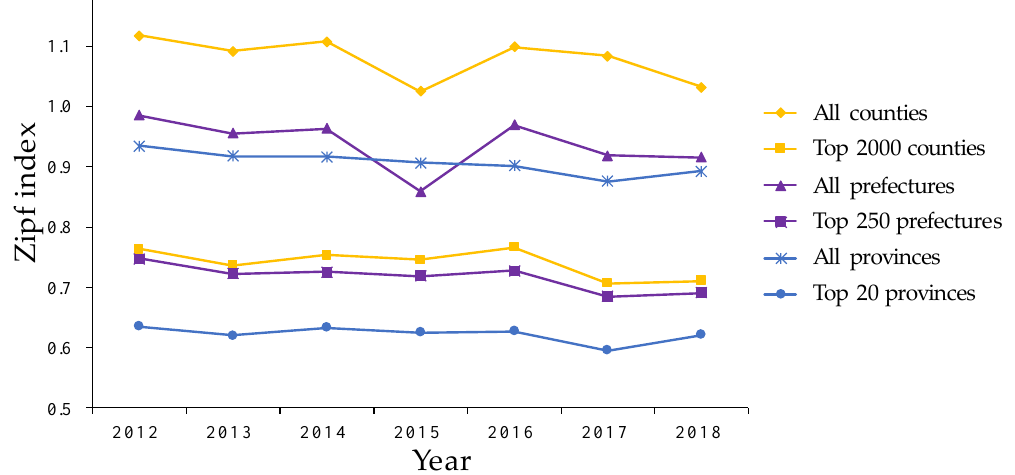
Figure 13. The Zipf index of urban development at multiple scales.